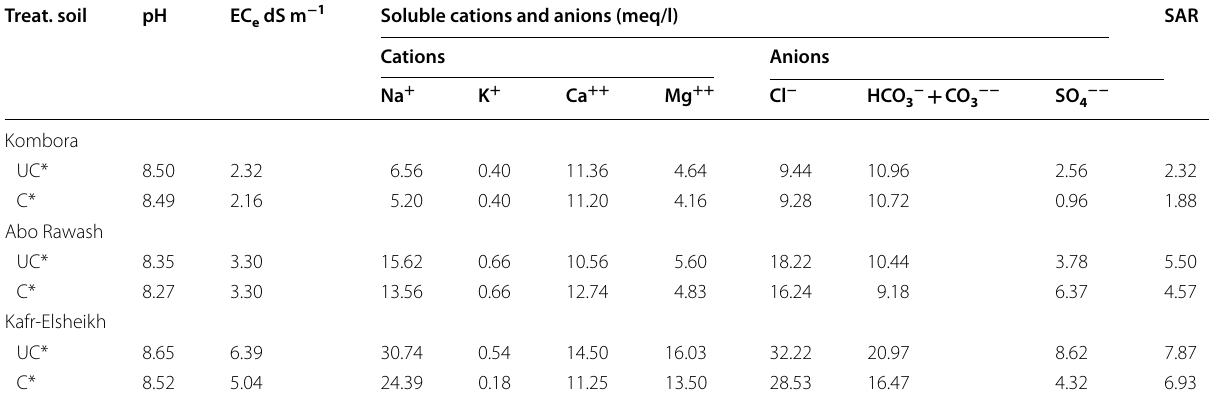
UC uncultivated soil, C cultivated soil